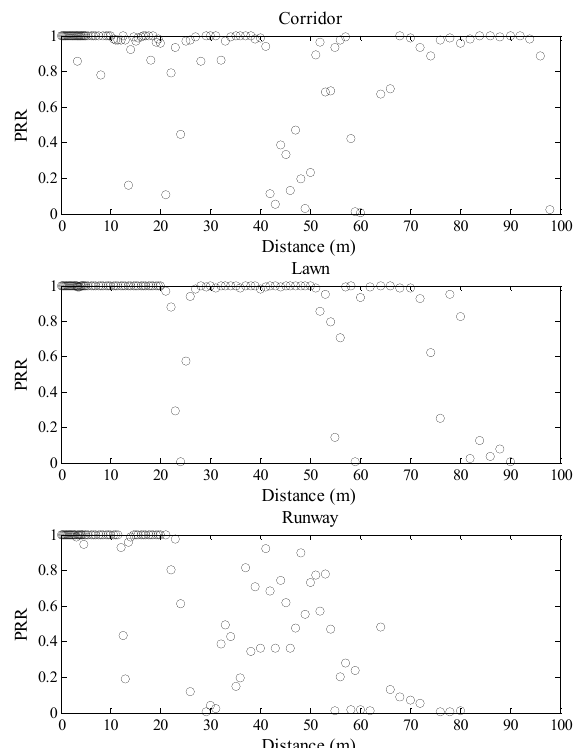
Figure 4. Communication distance vs. PRR in different environments.